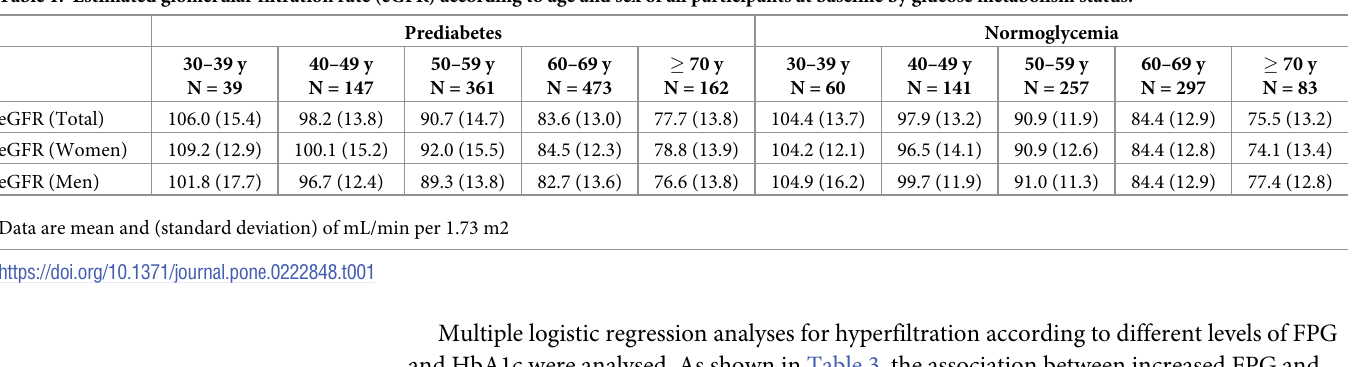
and HbA1c were analysed. As shown in Table 3, the association between increased FPG and HbA1c and ORs of hyperfiltration was analyzed in three groups. In levels 1 and 2, both FPG Table 2. Characteristics of all participants according to filtration at baseline.